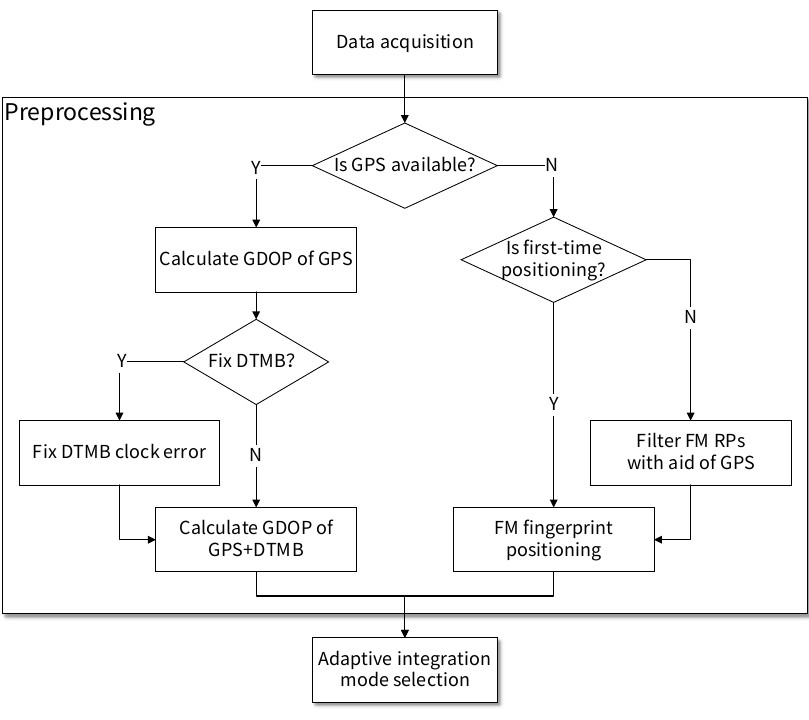
Figure 2. Flow chart of